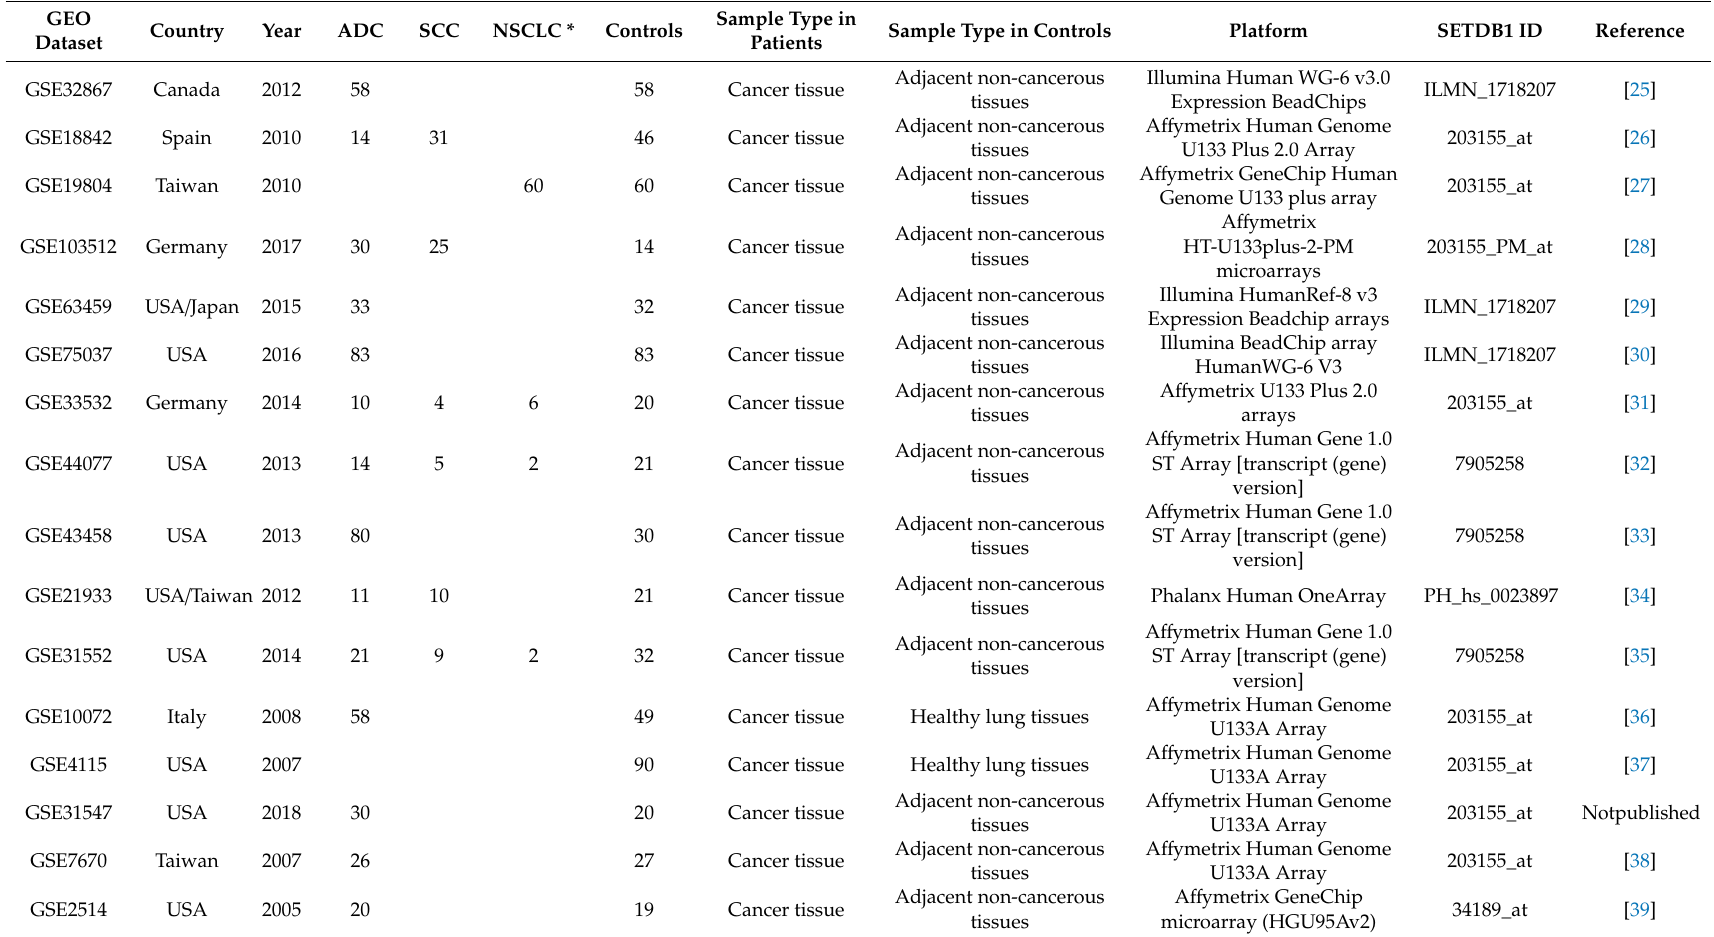
Table 1. Overview of the datasets selected from GEO for case-control